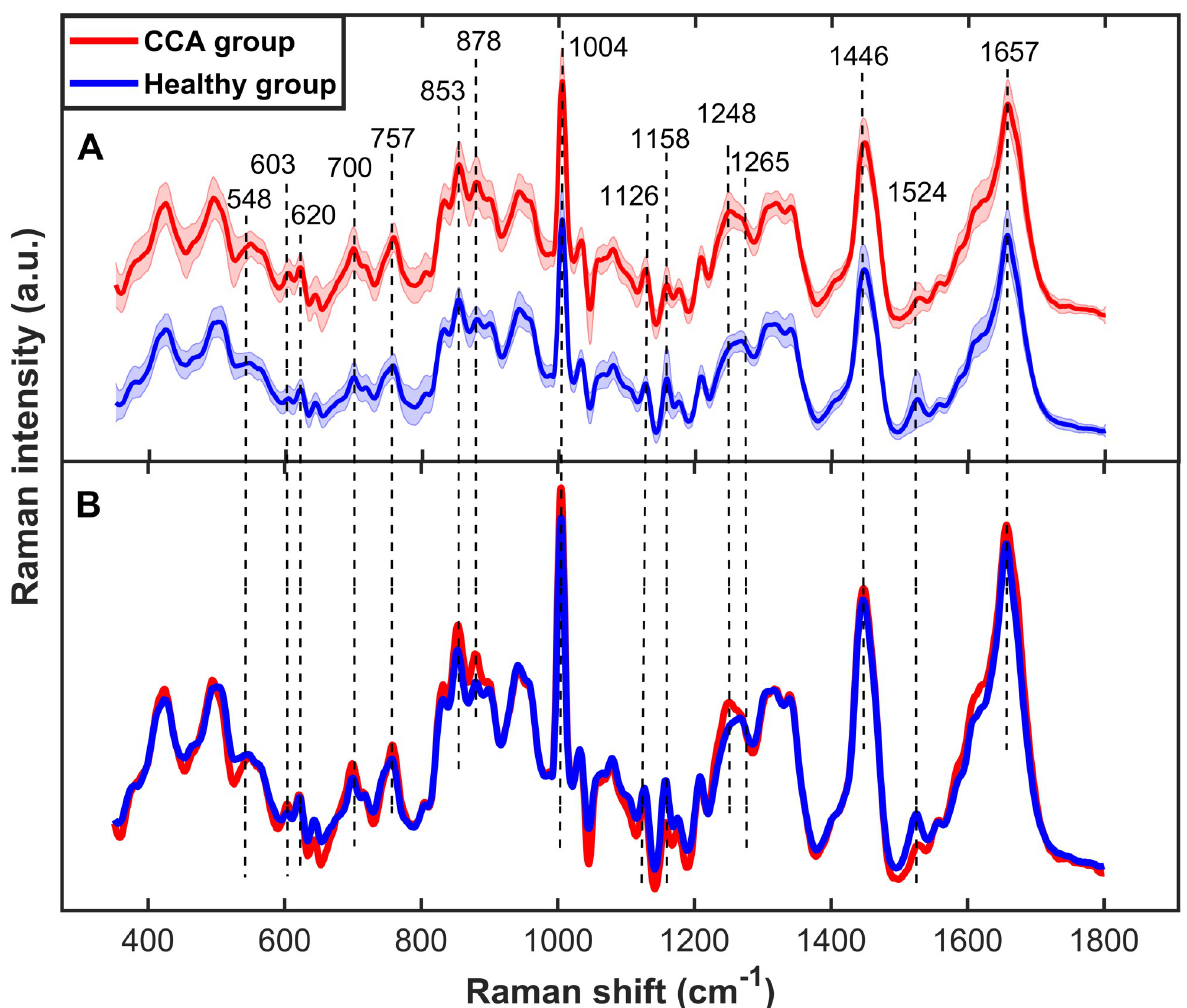
Fig 2. Mean serum Raman spectra of cholangiocarcinoma patients (red, n = 30) and healthy subjects (blue, n = 30). (A) Raman spectra that were offset for clarity of presentation. The solid lines and shaded regions show the averages and standard deviations of the data, respectively. (B) Superimposed average Raman spectra of the two